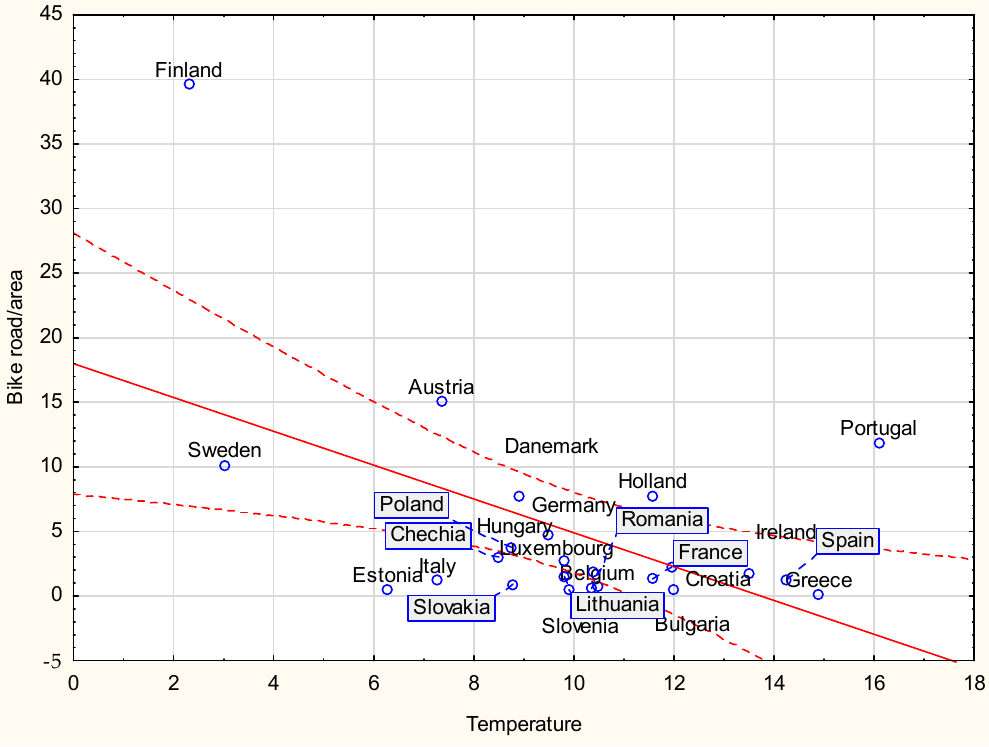
Figure 6. Scatter plot between the country’s average temperature and the average length of bikeways per square kilometer of area in the smart cities. Source: author’s analysis.